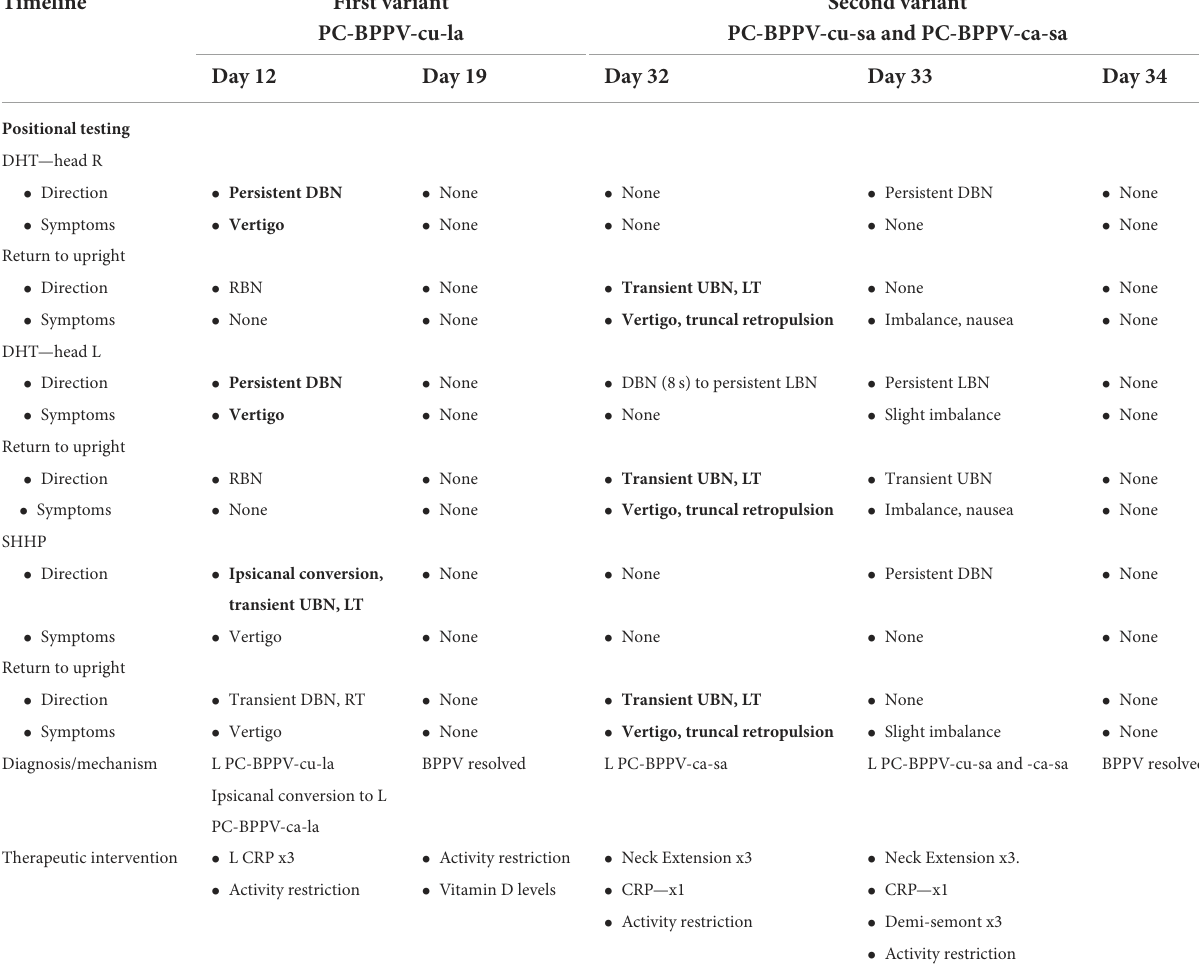
TABLE 1 Timeline for first and second episode of care including clinical findings, diagnostic assessment, and therapeutic intervention.